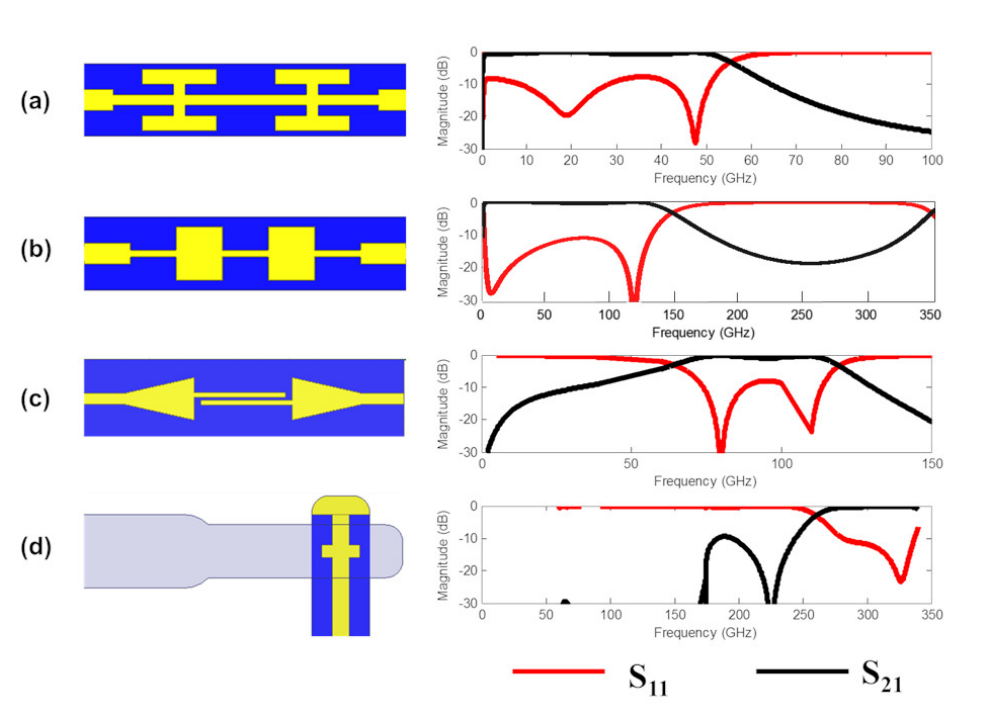
Figure 2. Top view and predicted response of the mixer passive circuits: ( a ) IF Hammer-head filter; ( b ) RF stepped impedance low-pass filter; ( c ) LO DC-Block and ( d ) RF waveguide to microstrip E-Probe